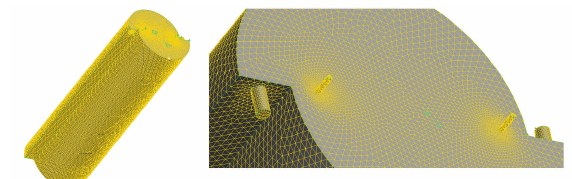
Figure 3: Schematic diagram of the computational domain of asym- metric vortex chamber.